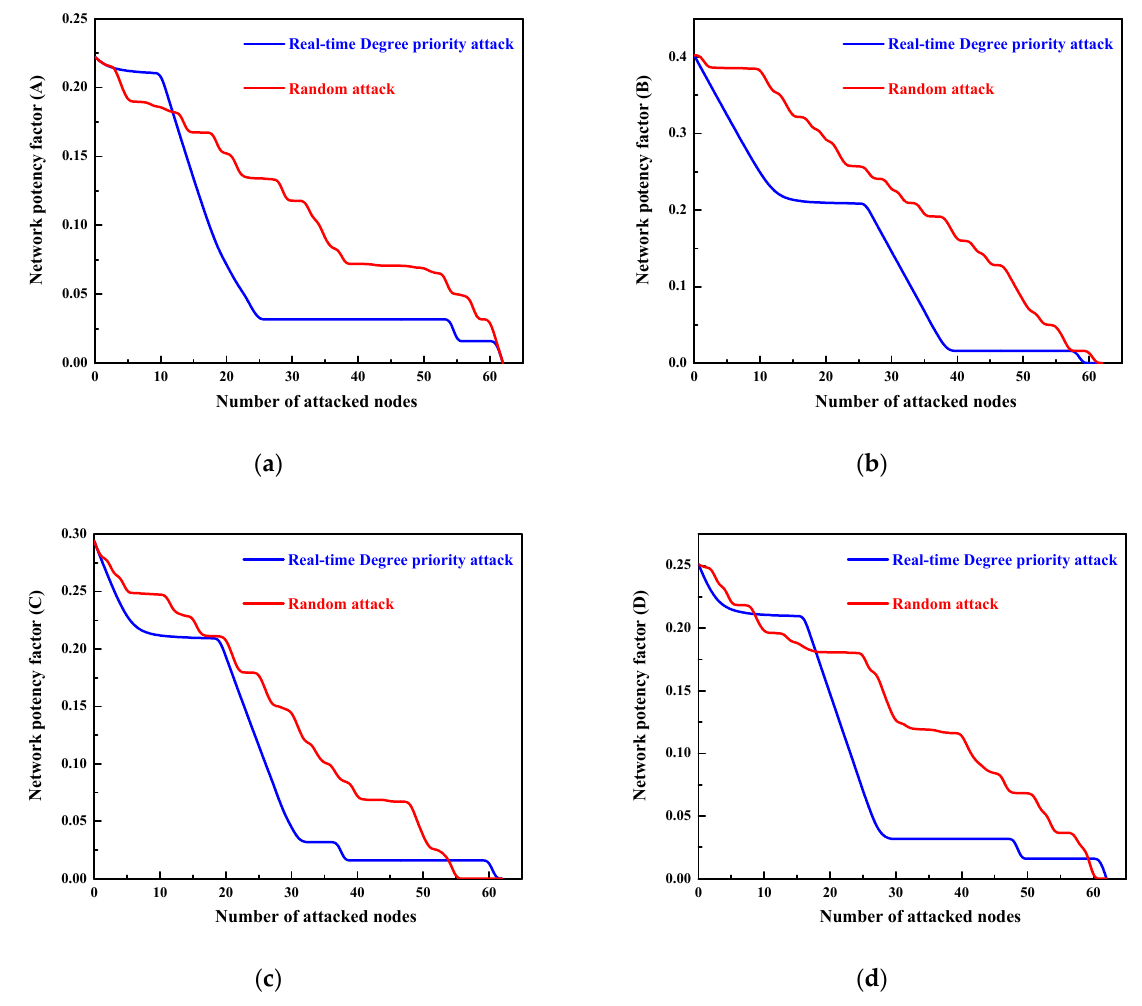
Figure 7. Graph of network potency factor under two attacks. ( a ) Network A; ( b ) Network B; ( c ) Network C; ( d ) Network D.